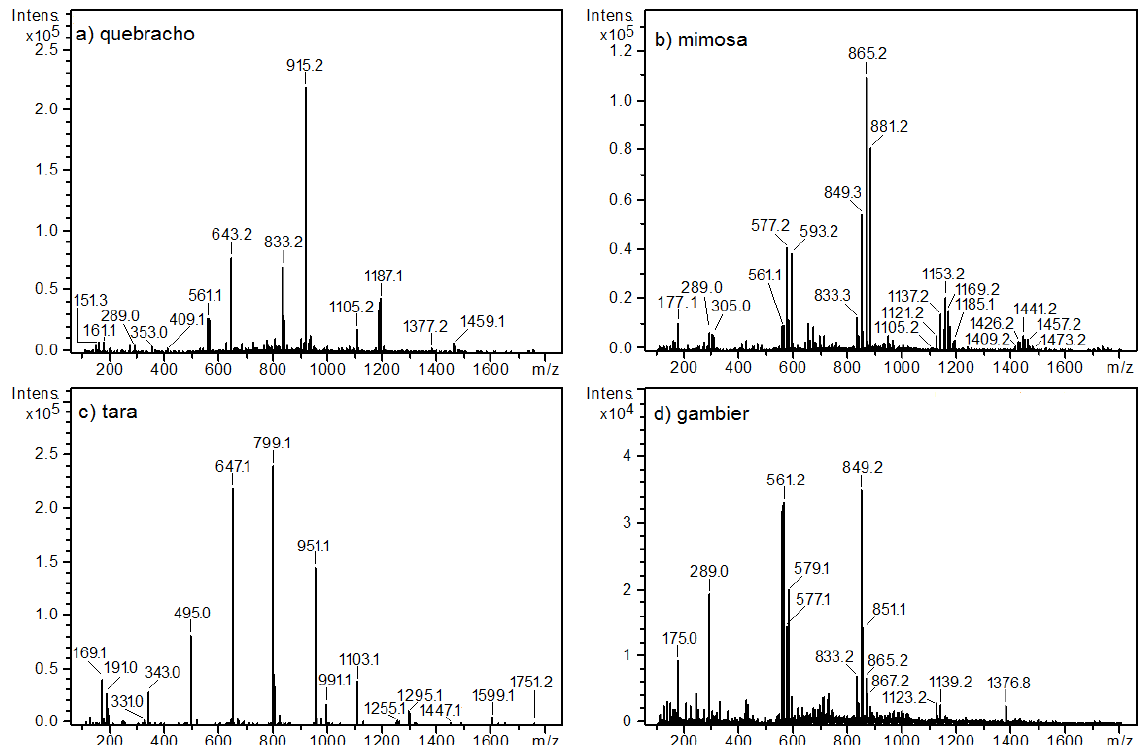
Fig. 2: Mass spectra of quebracho, mimosa, tara, and gambier extracts (hot water method) in negative mode ([ M – H ] – ).